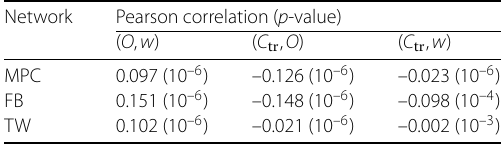
Table 1 Pearson correlations between transmission centrality, overlap and dyadic tie strength Network Pearson correlation ( p -value) ( O , w